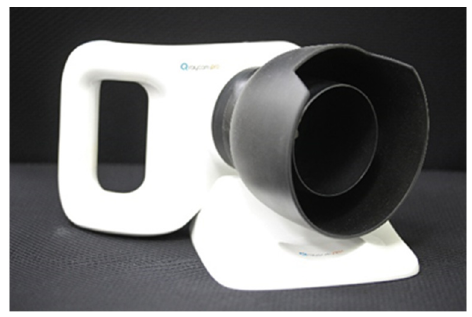
Figure 4. Q-ray cam, quantitative light-induced fluorescence device (AIOBIO, Seoul, Republic of Korea). QLF images of the frontal, left, and right views were acquired using a Q-ray